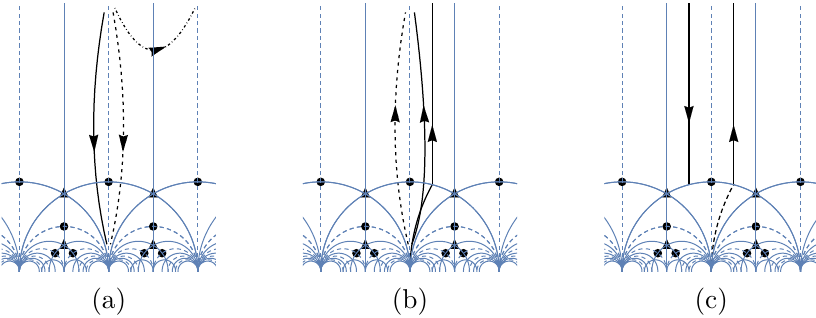
Figure 1 . Paths ˜ γ ˜ g , ˜ γ ˜ g and ˜ γ in the upper half plane t ∈ H are shown by dot-dashed, solid ˜ g − 1 2 ∞ 2 and dashed lines in (a) along with the boundaries of fundamental regions in thinner solid lines. The PSL 2 Z orbit of t [0] ∗ and t [1] ∗ are indicated by • ’s and N ’s, respectively. The contours of integration for the period polynomials P ˜ g ( t, f ∗ ) and P ( t, f ∗ ) are drawn by solid and dashed lines, respectively, ˜ g − 1 2 2 in (b). The contour for P ˜ g ( t, f ∗ ) may be split into two segments (solid and dashed) in (c), and the 2 integral over the dashed part of the contour may be further rewritten as an integral over the other solid line contour in